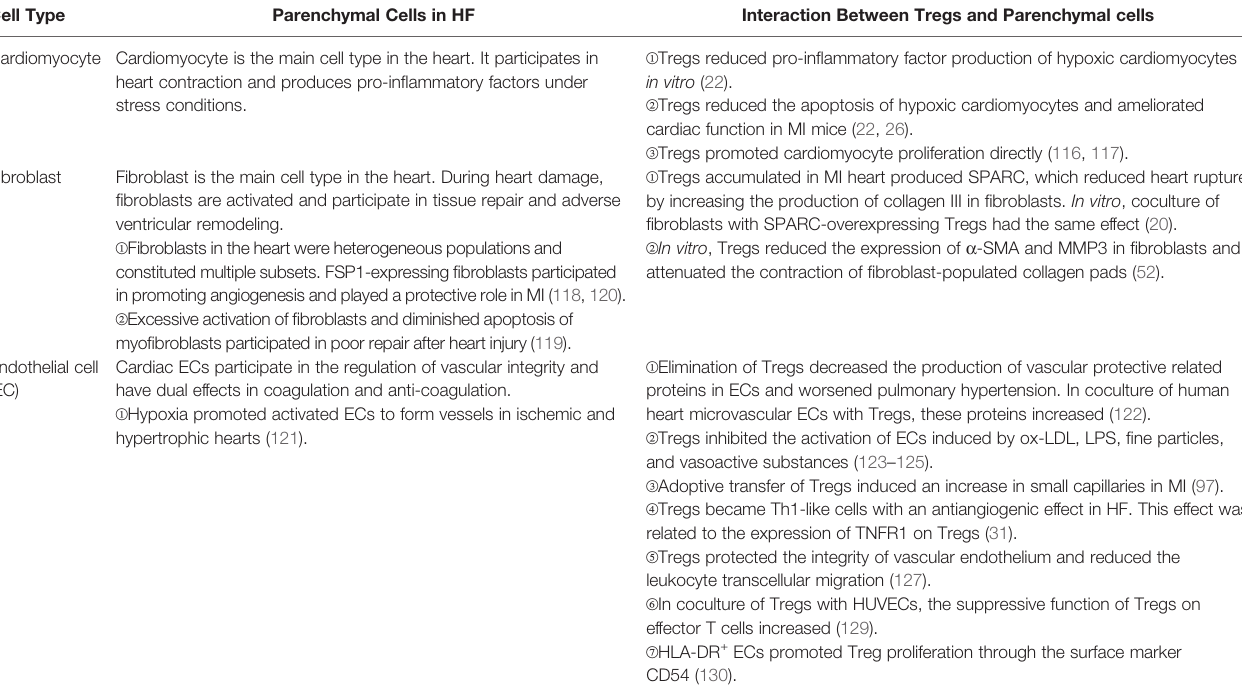
FIGURE 3 | Regulatory T cells (Tregs) interact with cardiac parenchymal cells. Tregs regulate the functions of cardiac parenchymal cells through cell-to-cell contact or molecule secretion. For cardiomyocytes, Tregs inhibit pro-in fl ammatory factor production and reduce the apoptosis of cardiomyocytes after heart injury in adult mice. Moreover, they directly promote the proliferation of cardiomyocytes in injured mice of a week old or pregnant. Tregs inhibit pro-in fl ammatory factor production of fi broblasts and promote collagen III synthesis in fi broblasts through secreted protein acidic and rich in cysteine (SPARC) secretion in the infarcted area. Tregs inhibit fi brosis of the interstitial zone by regulating fi broblast activation. Tregs inhibit the activation of endothelial cells (ECs) and reduce the migration of leukocytes. In the early stage of heart injury, Tregs promote angiogenesis. However, dysfunctional pro-in fl ammatory Tregs in heart failure inhibit the effect. TABLE 3 | The interaction between tregs and parenchymal cells in HF